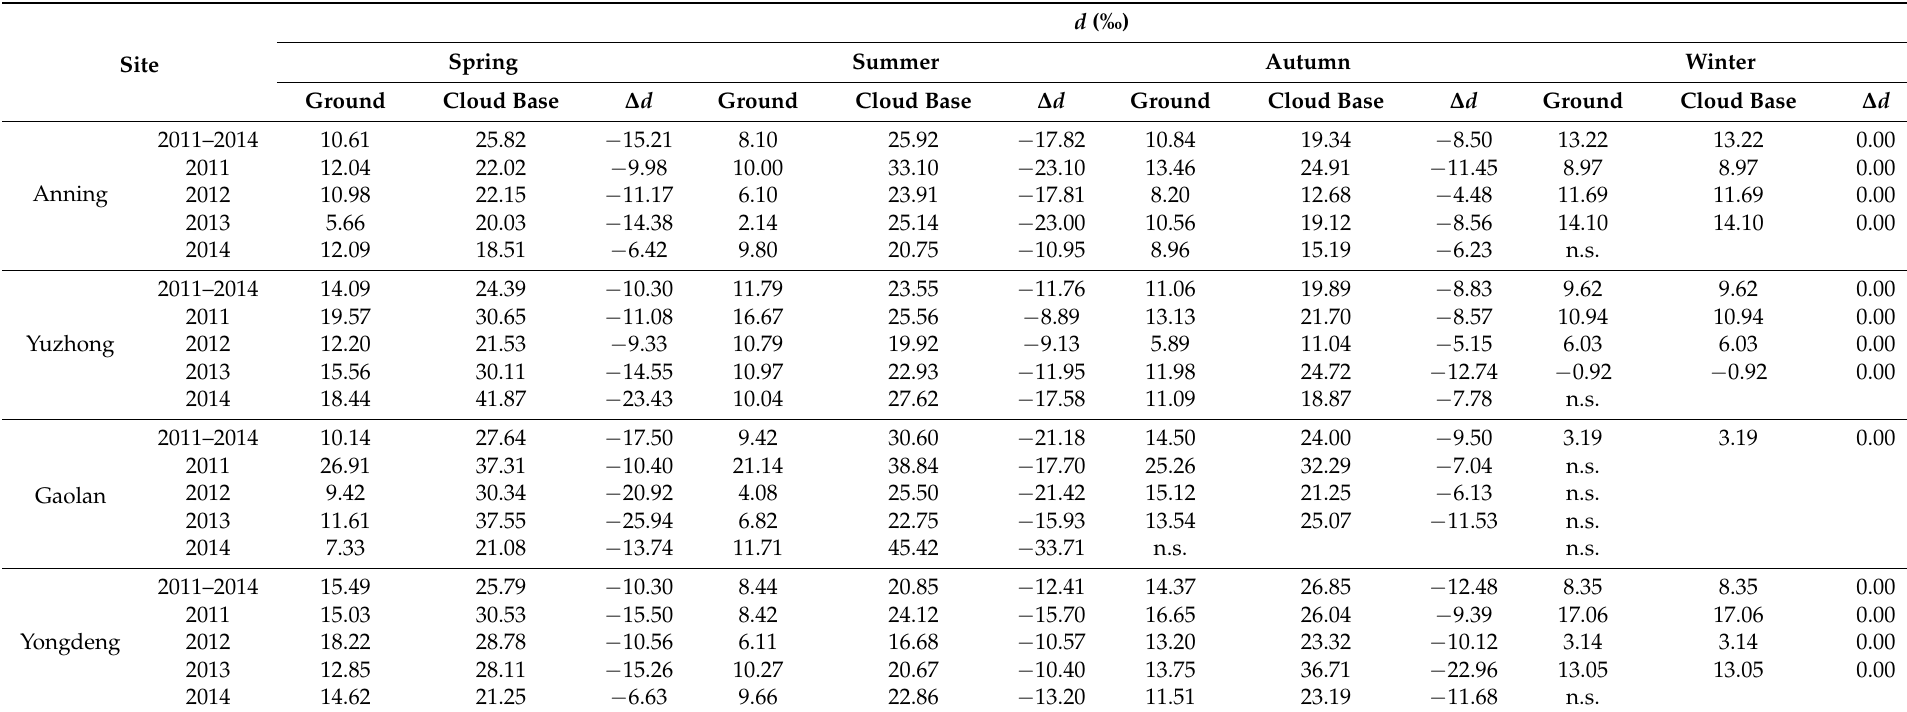
Table 2. Comparison of deuterium excess ( d ) in precipitation at land surface and cloud base for each